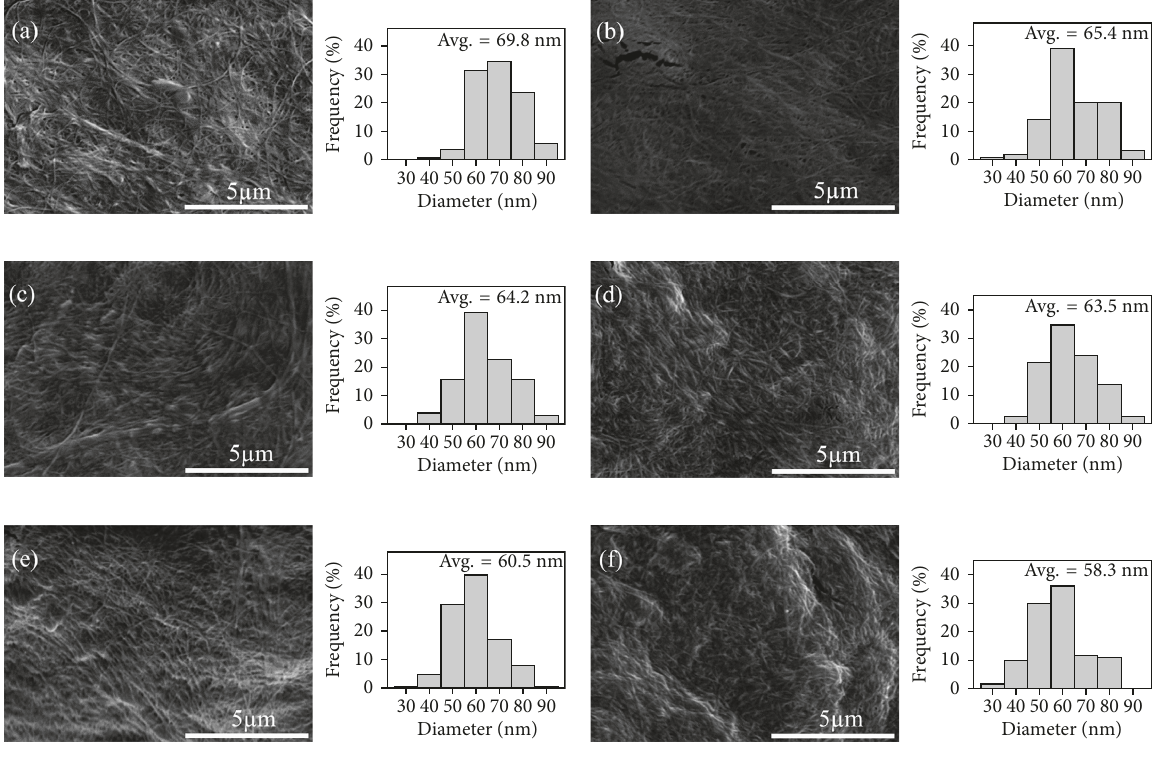
Figure 8: 10k magnification of SEM images of (a) DNDC (A0), (b) OC-6 hrs (D1), (c) OC-12 hrs (D2), (d) OC-24 hrs (A4), (e) OC-36 hrs (D3), and (f) OC-48 hrs (D4) and their diameter size distribution.